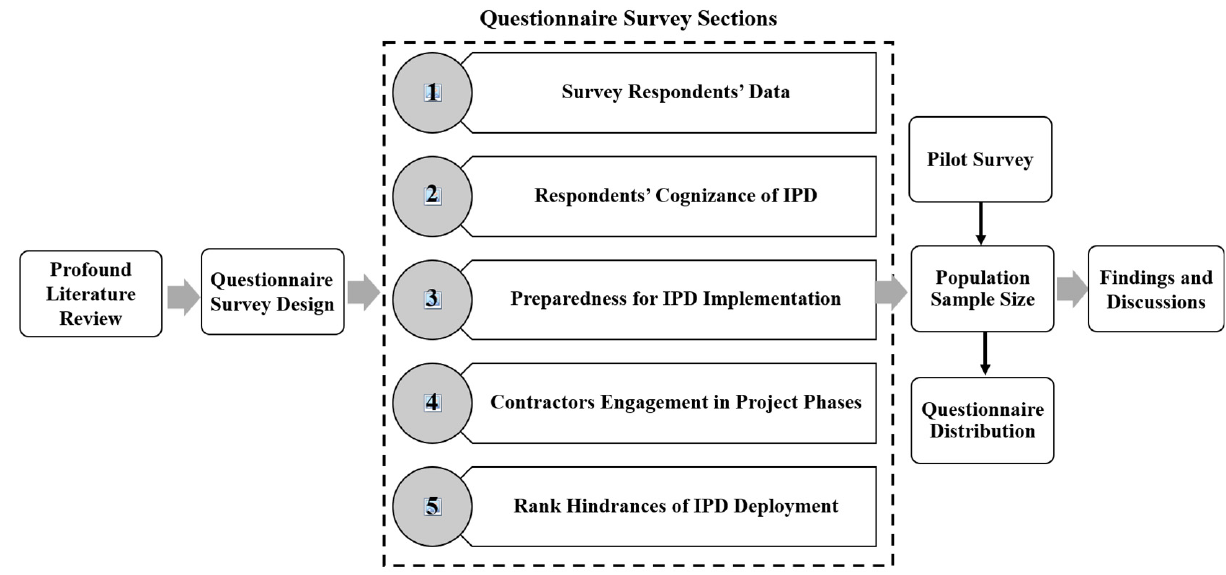
Figure 1. Research methodology.